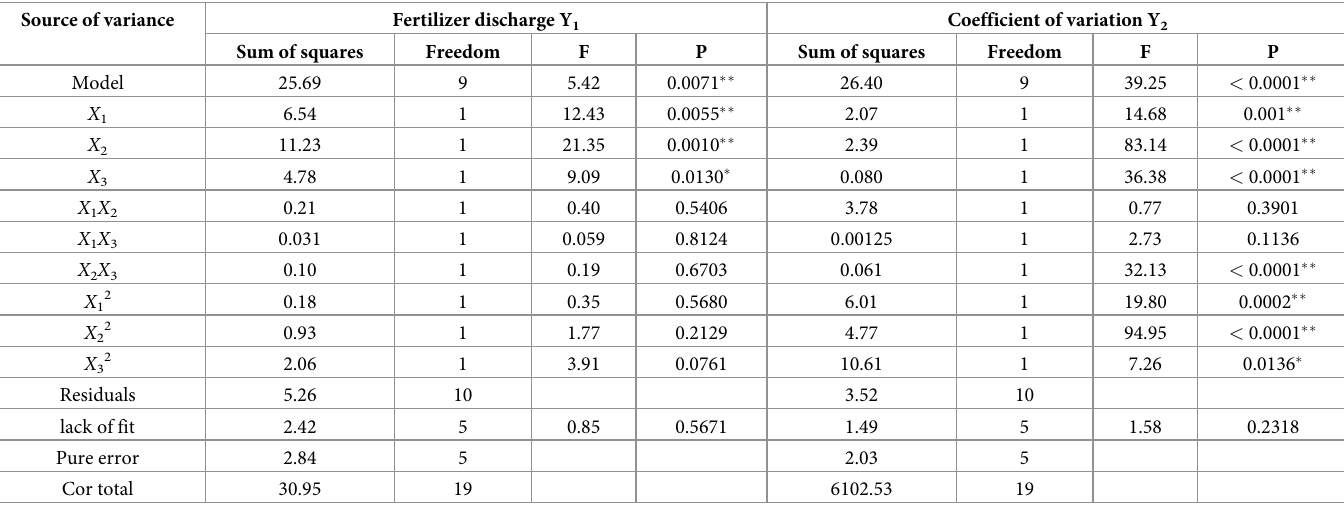
Table 5. Analysis of variance